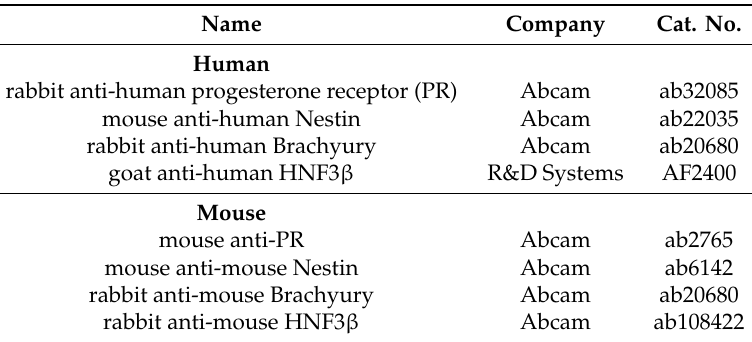
Table 1. Primary antibodies used for this study.